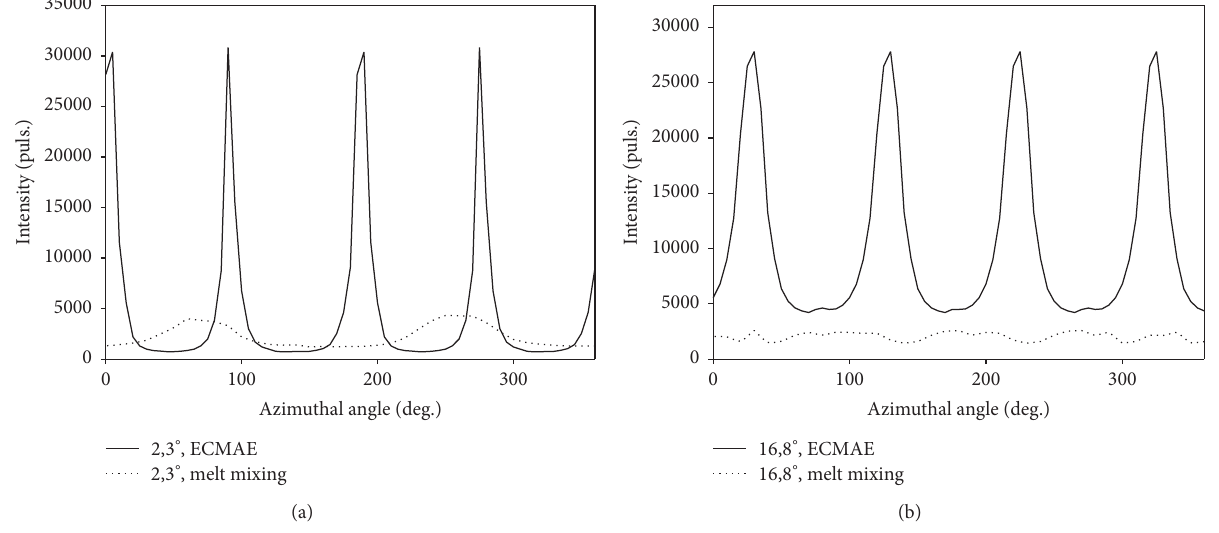
Figure 4: The results of azimuthal scanning of the detector located at fixed scattering